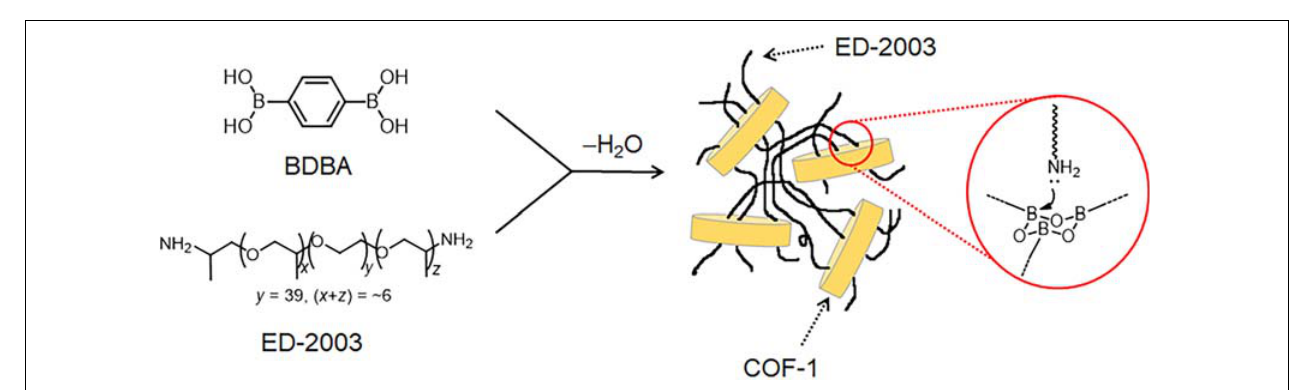
FIGURE 2 | Synthesis of SME based on COF-1 and ED-2003.